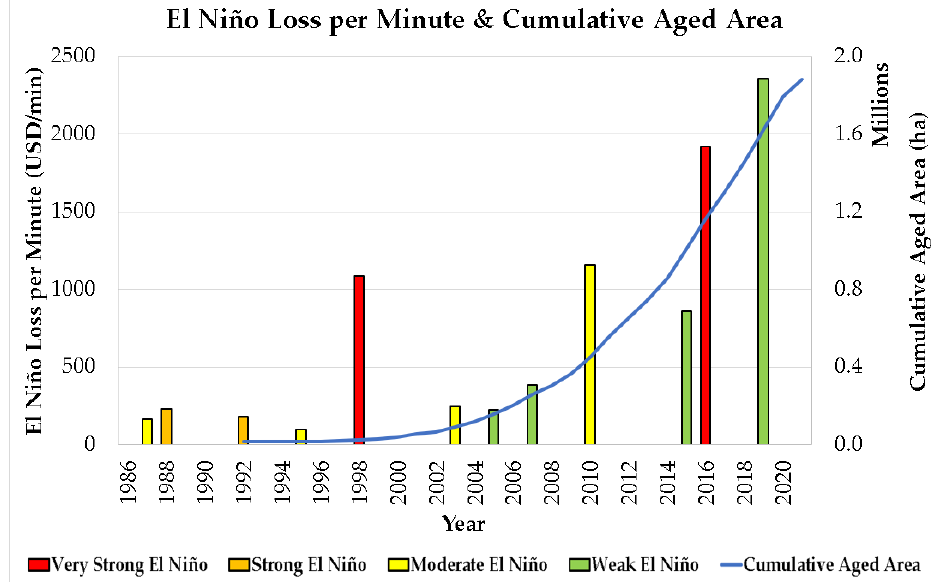
Figure 10. Comparison between El Niño loss per minute and cumulative aged area (no replanting scenario) [26].